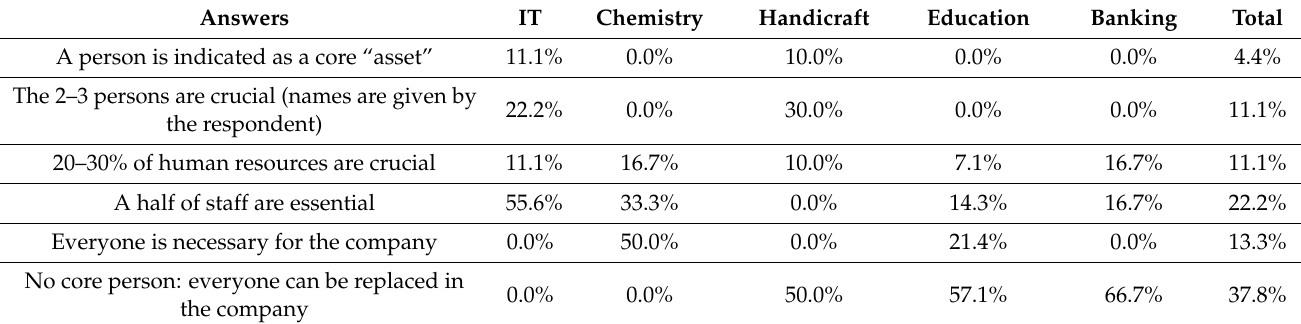
Table 8. Distribution of evaluation of unique human resources of